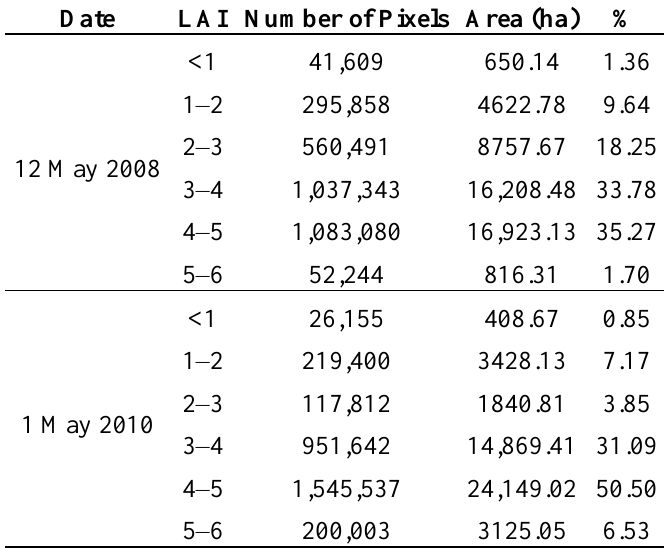
Table 7. Number of pixels and area in hectares and in percentage of particular LAI classes.